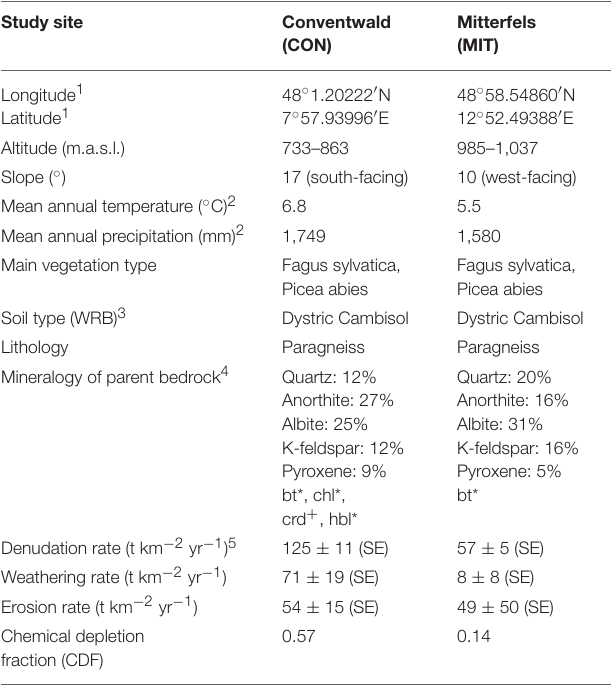
TABLE 2 | Characteristics of the study sites in the Black Forest (CON, Schwarzwald) and the Bavarian Forest (MIT, Bayerischer Wald). Study